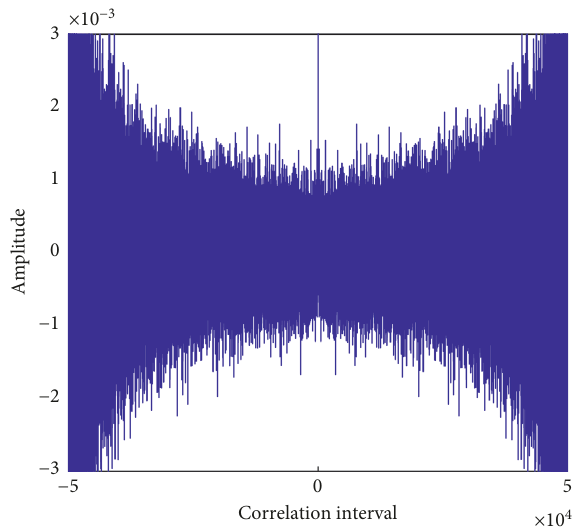
Figure 3: Self-correlations of sequence K